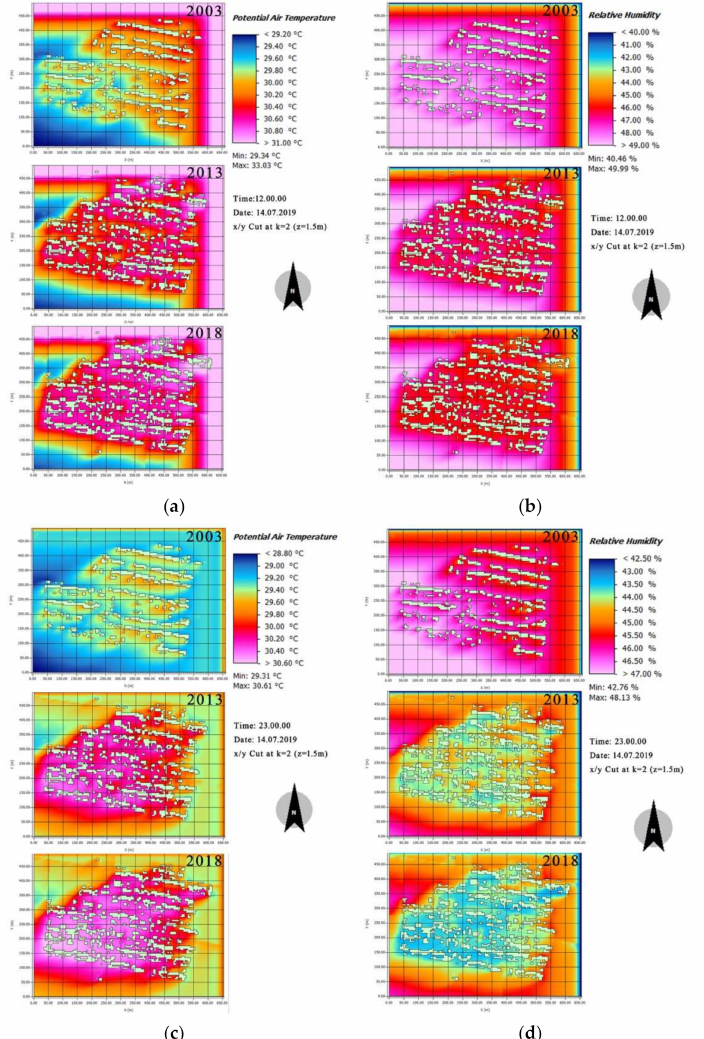
Figure 6. Distribution maps of air temperature (AT) and relative humidity (RH) at 1.5 m from the ground in the study area. ( a ) Air temperature at daytime (12:00). ( b ) Air temperature at nighttime (23:00). ( c ) Relative humidity at daytime (12:00). ( d ) Relative humidity at nighttime